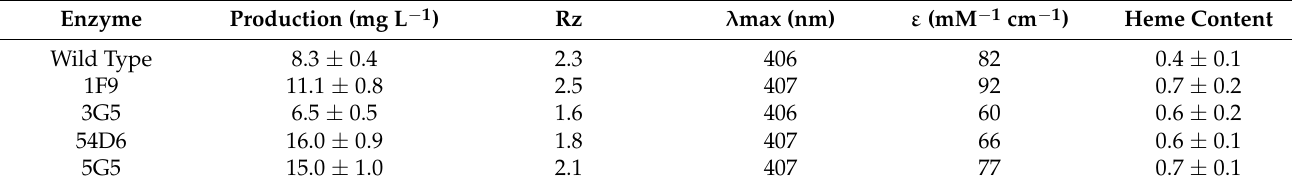
Table 1. Spectroscopic and redox properties of purified Bs DyP wild type and variants.